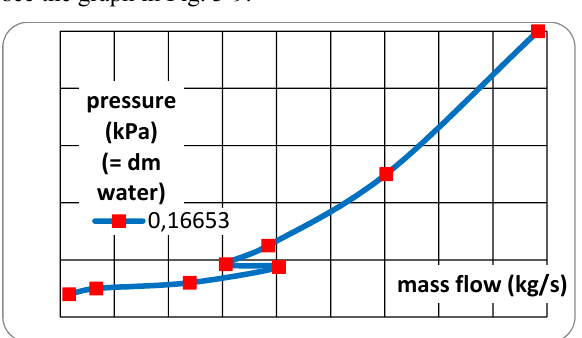
Fig. 3-9. Resistance characteristic of the vortex valve (numerical simulations).